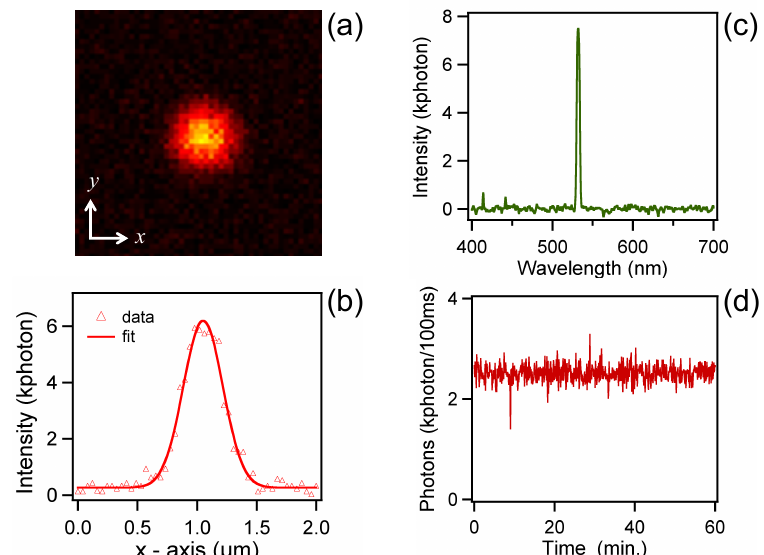
Figure 2. ( a ) Second-harmonic image of a KTP NP with a size of about 100 nm, obtained by scanning with a pulsed 1064 nm laser. ( b ) The SHG intensity profile in the x -direction, extracted from ( a ), showing a FWHM of 500 nm. ( c ) SHG spectrum. ( d ) Time evolution of the SHG signal obtained by an average power of 0.3 mW. The signal is stable for a long